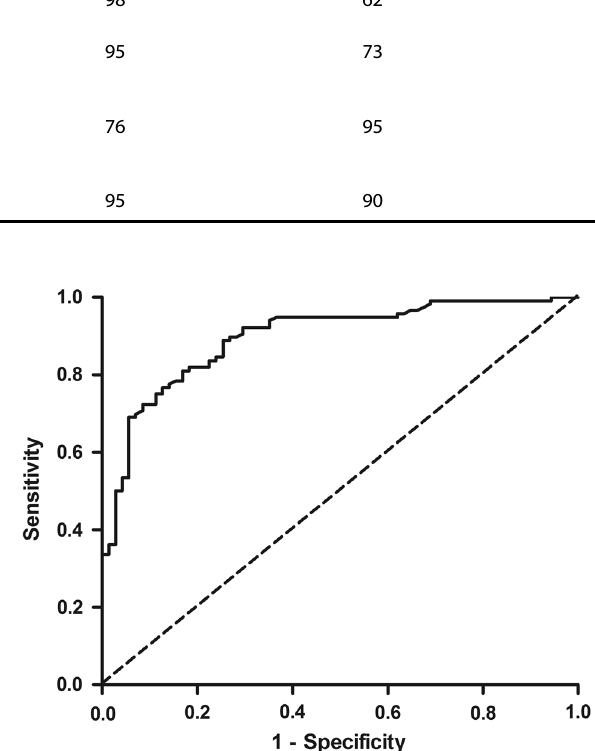
Fig. 4 ROC of FEV 1 / FEV 6 measured by COPD6 device for detection of